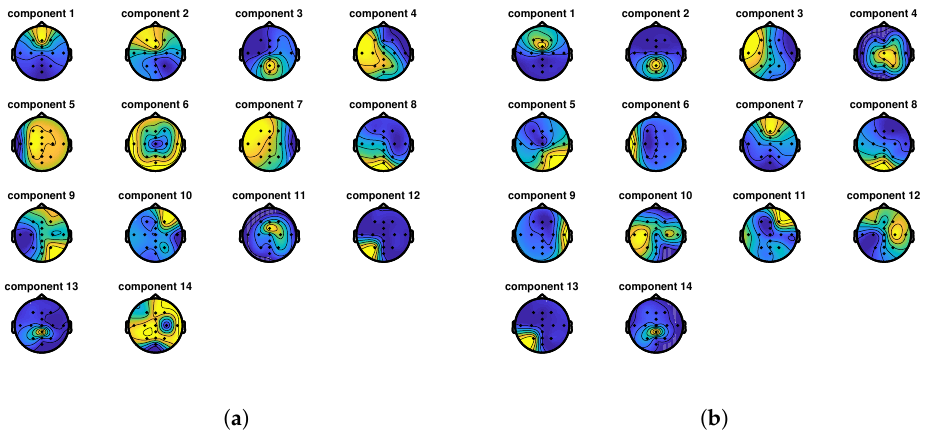
Figure 13. Illustration of spatial topography differences of the components obtained by applying the unmixing matrices W ( a ) and W (cid:48) , with handmade detection of eye-artifacts ( b